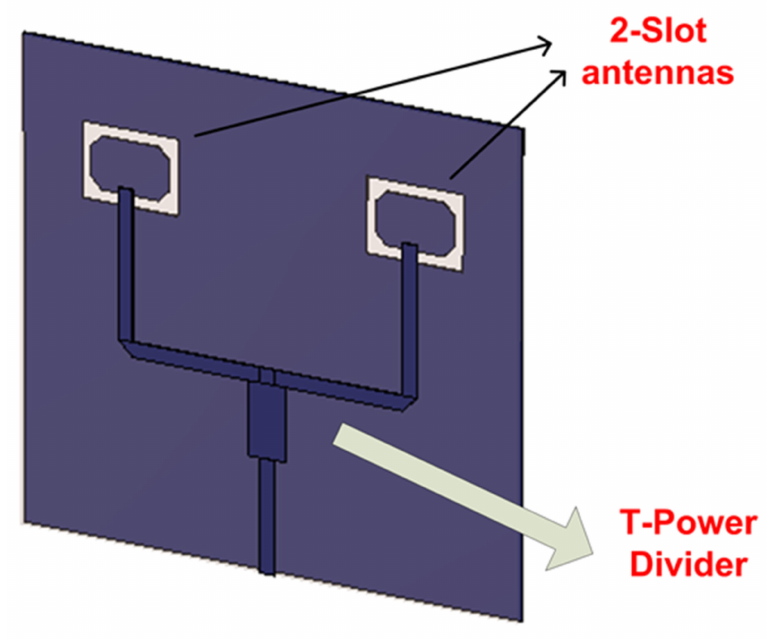
Figure 4. The geometry of the 1 × 2